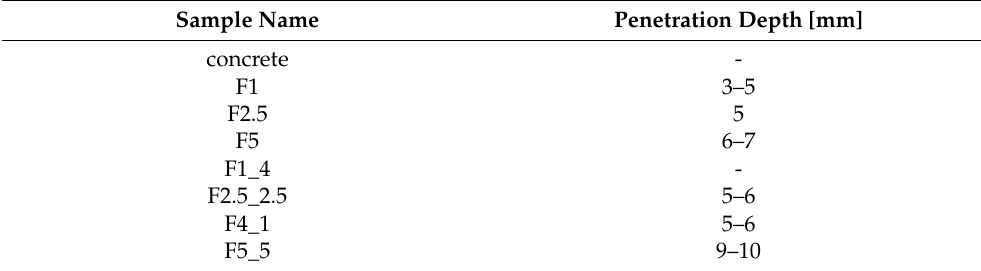
Table 4. The penetration depth of the silane into the